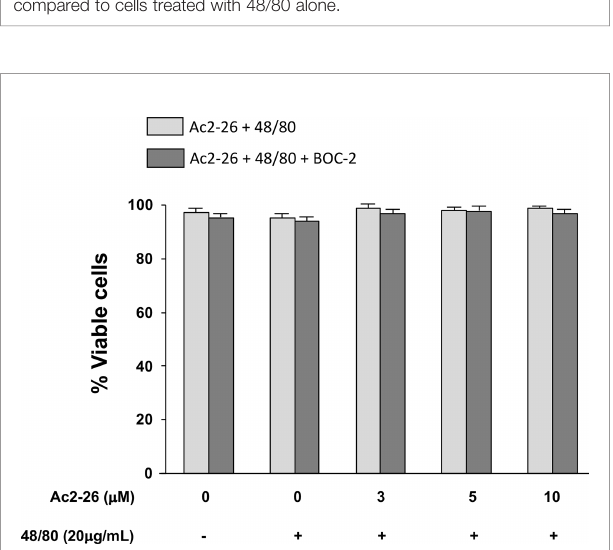
FIGURE 4 | Exogenous AnxA1 (peptide Ac2-26) inhibits HMC-1 cell line degranulation induced by compound 48/80. HMC-1 cells were pre-treated with 3, 5, or 10µM peptide Ac2-26 for 30 min in the absence or presence of FPRs antagonist BOC-2 (5µg/mL). Degranulation was assessed measuring the activity of b -hexosaminidase in culture supernatants. Results are expressed as percentage of enzyme release. All experiments were conducted in triplicate. Data are expressed as the mean ± S.D from four different experiments and analyzed using one-way ANOVA. ***p <0.001 compared to cells treated with 48/80 alone or 48/80 + Ac2-26 (3 or 5 µM); **p <0.01 compared to cells treated with 48/80 + Ac2-26 (10 µM) + BOC-2; ## p <0.01 compared to cells treated with 48/80 alone.